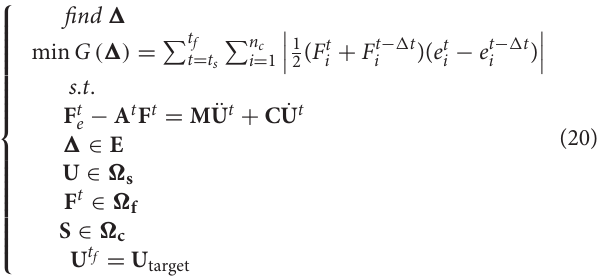
Compressive strength (N)